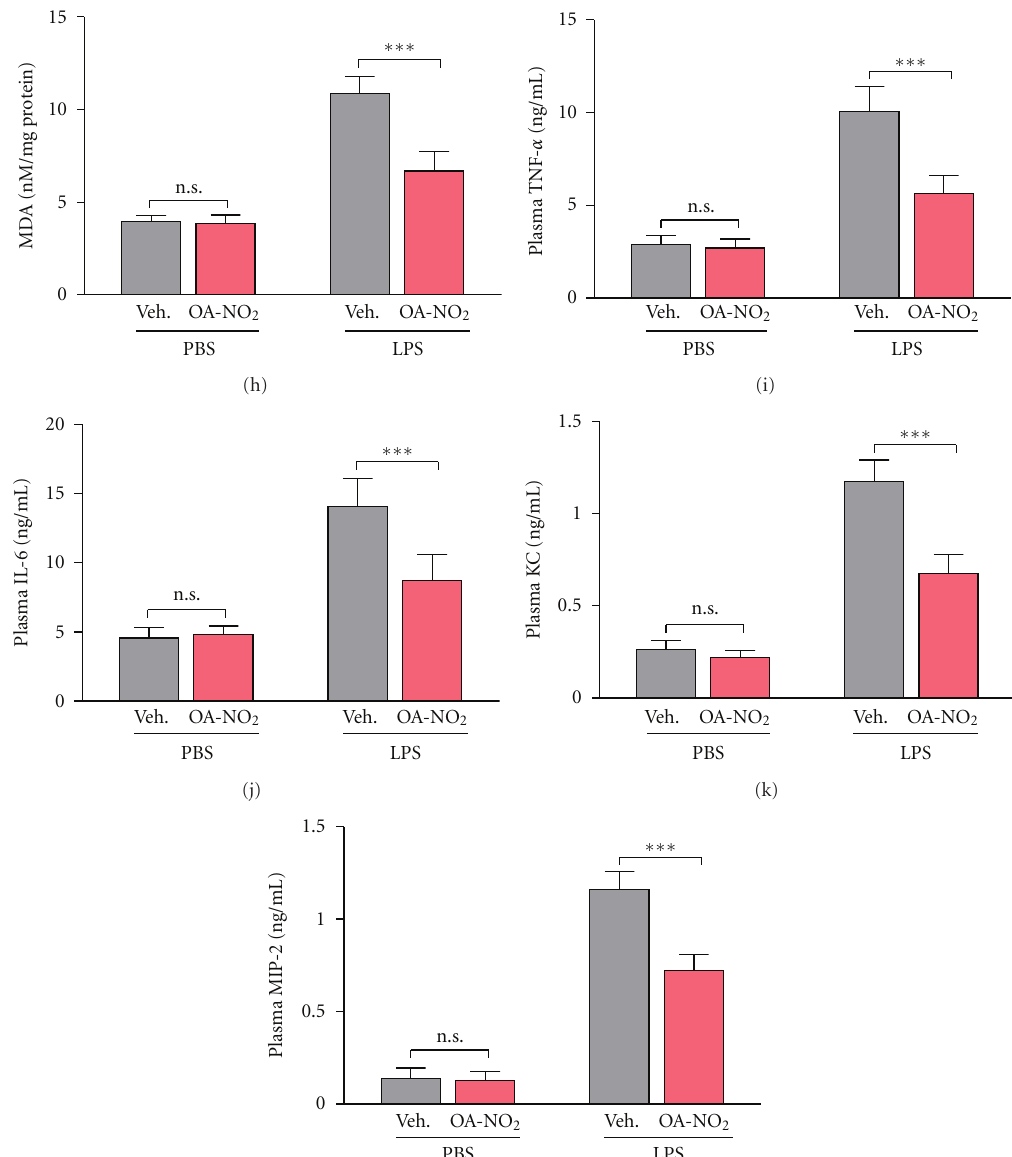
Figure 2: Pulmonary delivery of OA-NO 2 reduces LPS-induced lung inflammation. Induction of ALI by i.t. injection of LPS (50 μ g) was followed 30min later by i.t. administration (50 μ L) of OA-NO 2 (50 μ g) or vehicle (10% DMSO). After a further 5.5h, BAL fluid, plasma, and lung samples were obtained. (a) Total cell and (b) neutrophil number in BAL fluid. Myeloperoxidase activity in (c) lung tissue and (d) BAL fluid. (e) Microscopic examination following staining of BAL fluid. (f) H 2 O 2 production, (g) nitrate concentration, and (h) malonaldehyde/protein ratio in lung. Plasma levels of (i) TNF- α , (j) IL-6, (k) KC, and (l) MIP-2. Data are representative of one of two independent experiments with n = 6–8 mice per group; ∗∗∗ P <